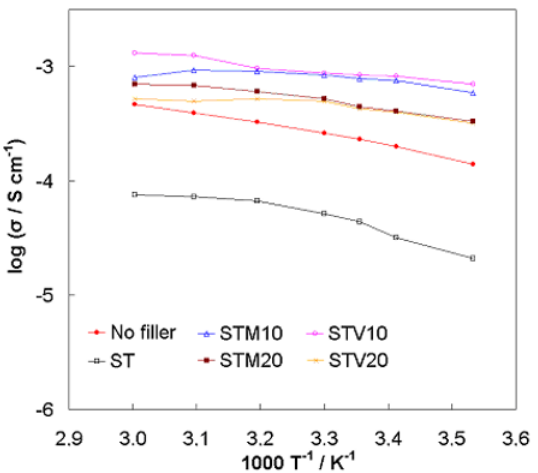
Figure 5. Temperature dependencies of ionic conductivities determined for the gel electrolytes with various fillers, presented as Arhenius plots